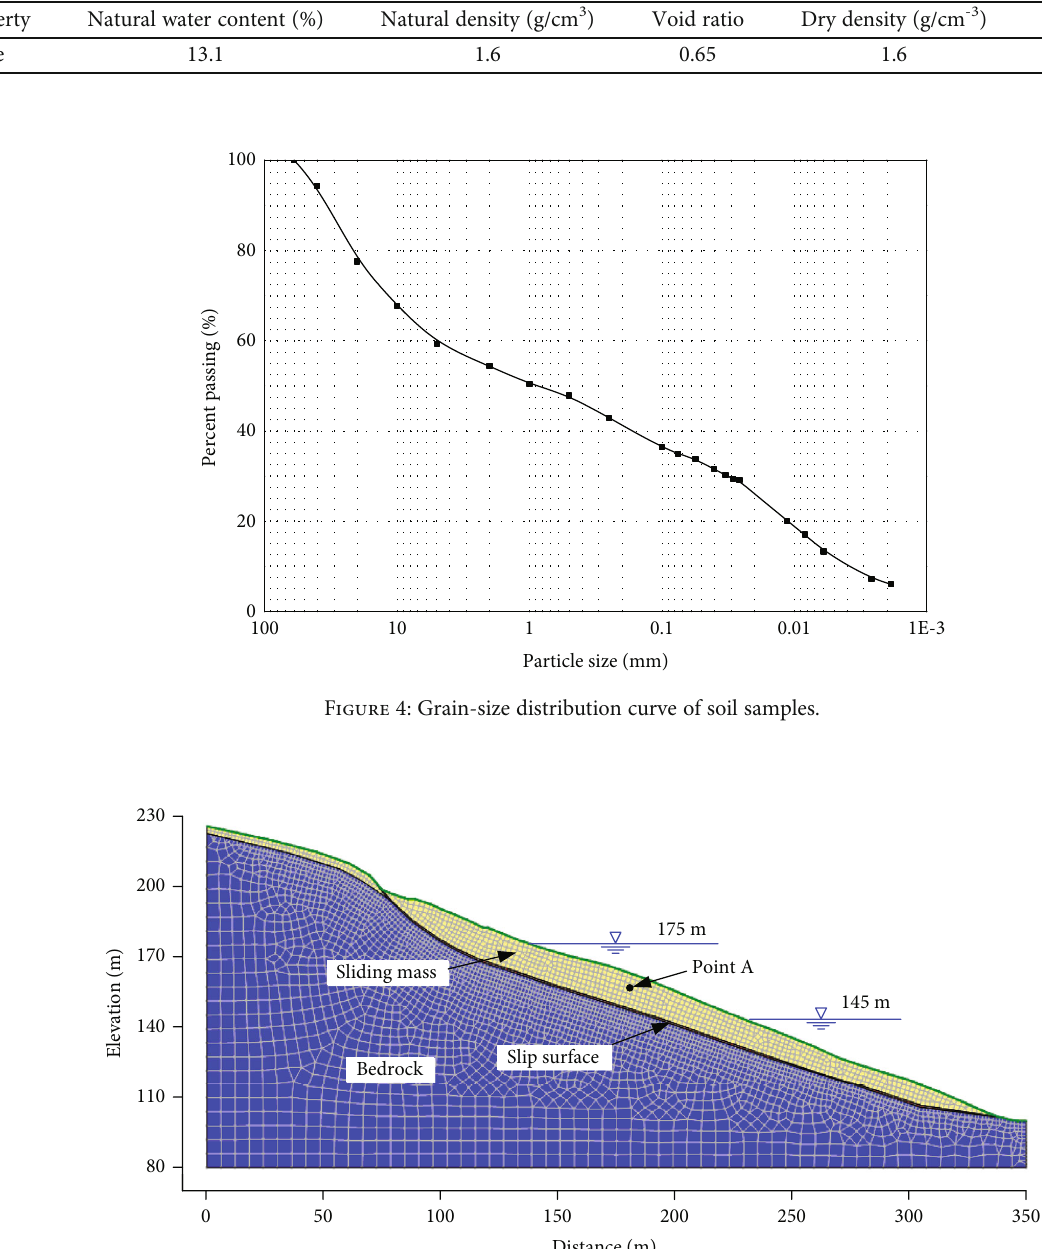
Table 1: Physical parameters of soil samples.